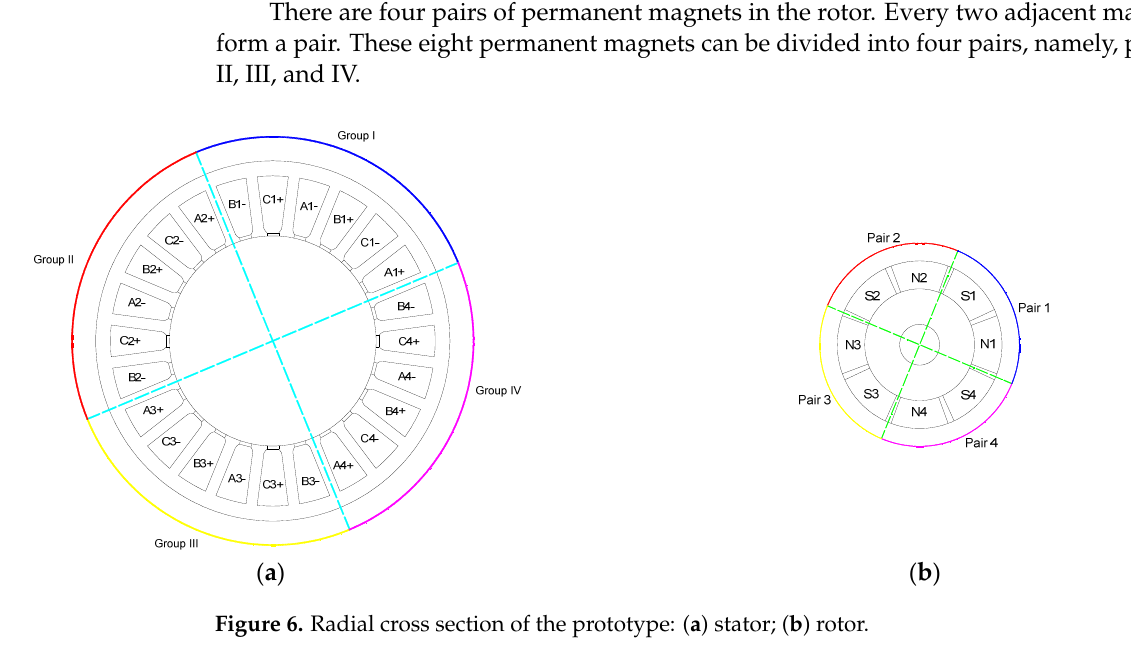
( b ) Figure 7. Distribution of magnetic flux density: ( a ) healthy; ( b ) eccentric distance is 0.2 mm. Taking the geometric center of the eccentric rotor as the center, we established a cir- cular closed path in the middle of air gap as sampling position. The data sequence of nor- mal component of magnetic flux density is shown in Figure 8. In the figure, different val- ues of eccentric distance are compared. Eccentric distance equal to zero indicates that the electromotor is healthy. Where the air-gap thickness decreases, the density increases, and vice versa. Near region N1, the thickness decreases the most and the density increases the Color Shade Results Quantity : |Flux density| Tesla Time (s.) : 360 Pos (deg): 359.999Scale / Color371.48945E-9 / 119.36062E-3119.36062E-3 / 238.72086E-3238.72086E-3 / 358.0811E-3358.0811E-3 / 477.44134E-3477.44134E-3 / 596.80158E-3596.80158E-3 / 716.16185E-3716.16185E-3 / 835.52206E-3835.52206E-3 / 954.88232E-3954.88232E-3 / 1.074241.07424 / 1.19361.1936 / 1.312961.31296 / 1.43232 1.43232 / 1.551681.55168 / 1.671041.67104 / 1.79041.7904 / 1.90976 Color Shade Results Quantity : |Flux density| Tesla Time (s.) : 360 Pos (deg): 359.999Scale / Color85.9031E-9 / 118.44877E-3118.44877E-3 / 236.89747E-3236.89747E-3 / 355.34614E-3355.34614E-3 / 473.79482E-3473.79482E-3 / 592.24349E-3592.24349E-3 / 710.69217E-3710.69217E-3 / 829.14084E-3829.14084E-3 / 947.58958E-3947.58958E-3 / 1.066041.06604 / 1.184491.18449 / 1.302941.30294 / 1.421381.42138 / 1.539831.53983 / 1.658281.65828 / 1.776731.77673 / 1.89518